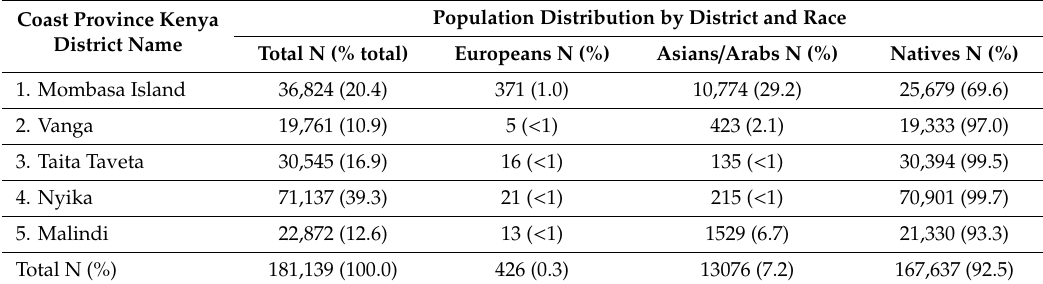
Table 1. Coast Province Kenya population distribution by district and race, 1918 to